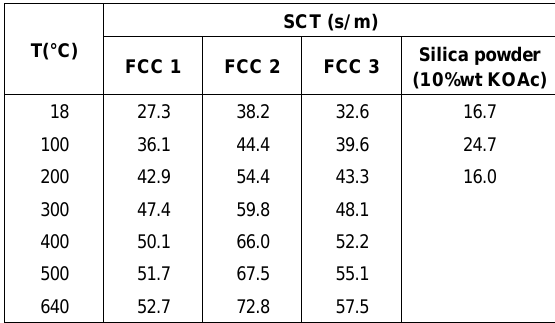
Table 1 Experimental SCT for FCC powders and a silica powder coated with